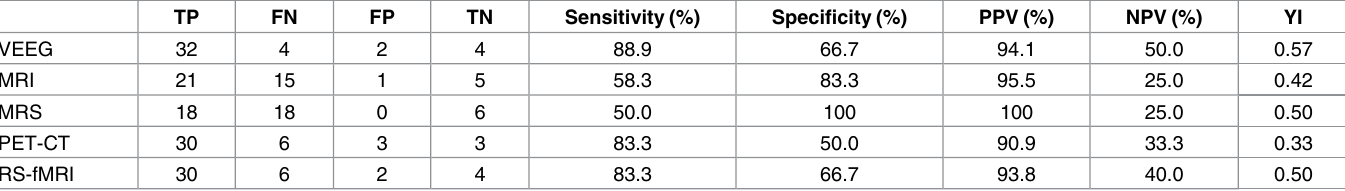
Table 2. Performanceof various imaging techniques for EZ localization.